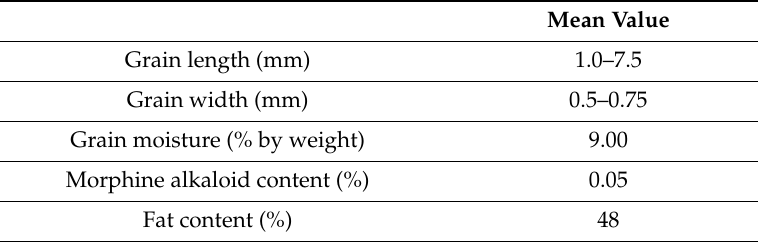
Table 3. Selected properties of Przemko cultivar of poppy and of